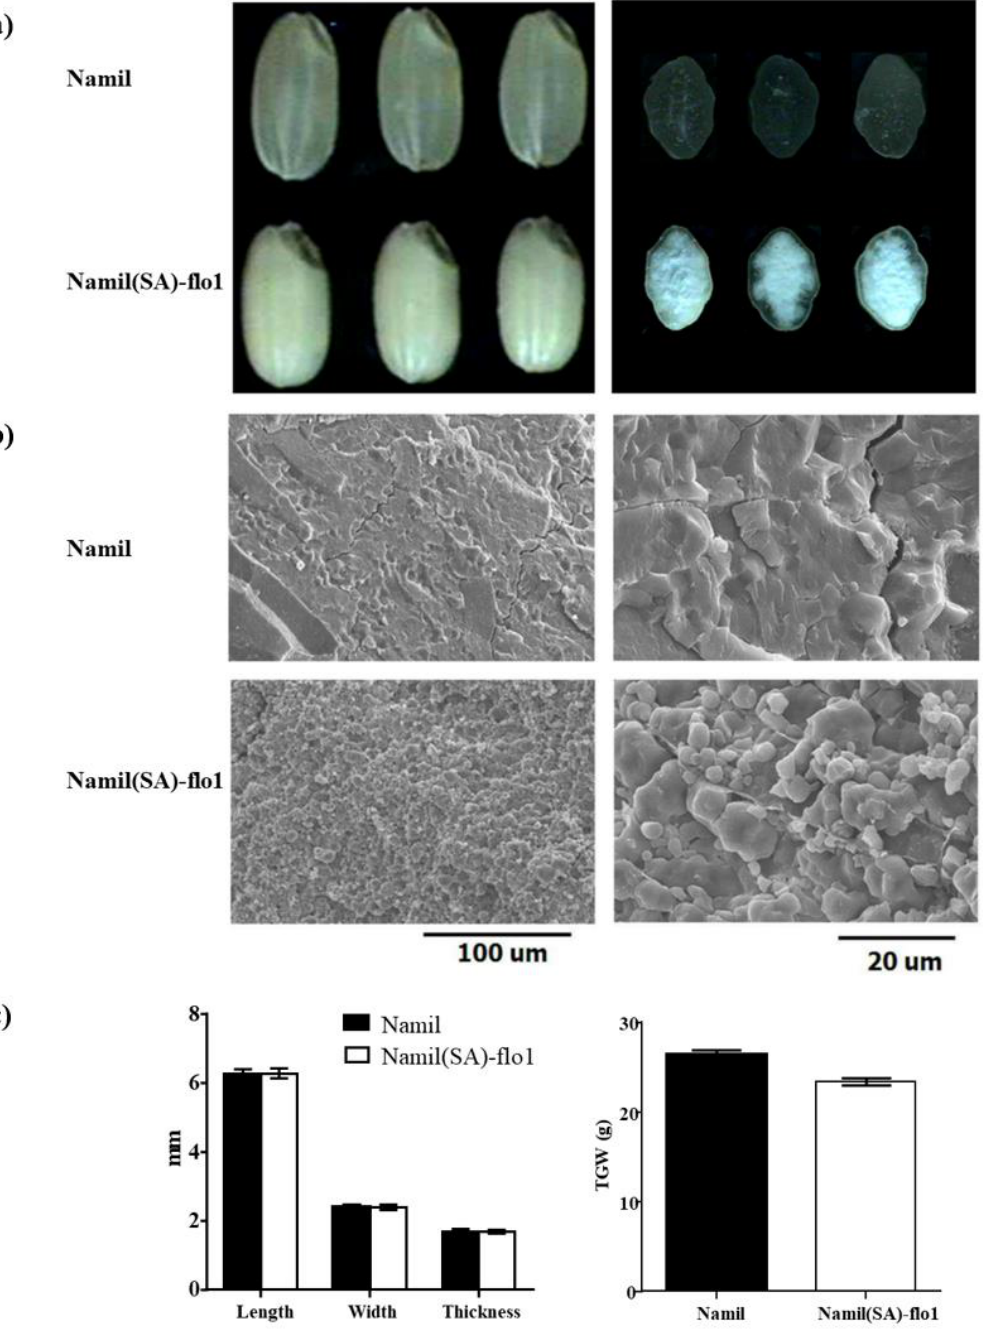
Figure 1. Phenotypic analyses of the mutant Namil(SA)-flo1 and wide type Namil. ( a ) Brown rice and transverse sections of Namil(SA)-flo1 and Namil; ( b ) Electron microscope visualization of mature endosperm. The Namil(SA)-flo1 is packed loosely with compound starch granules; ( c ) The grains’ shape and weight (TGW: 1000-grain weight of brown rice).